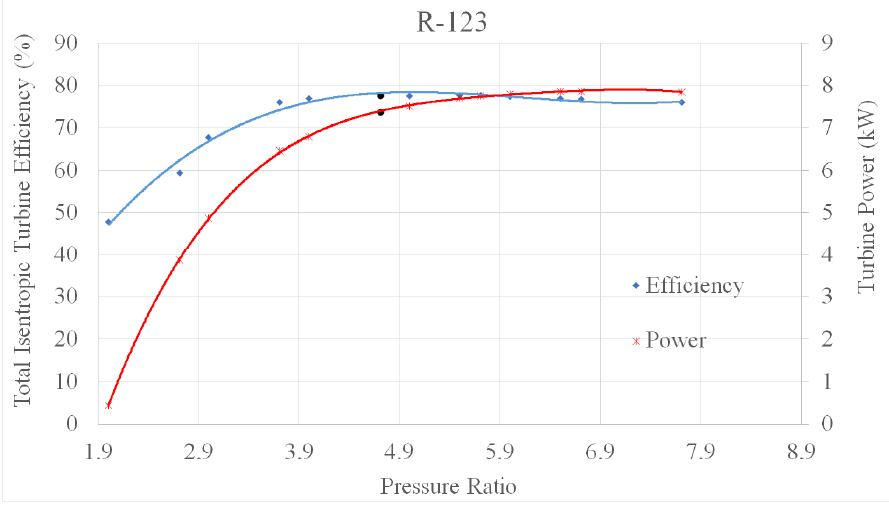
Figure 17. Variation in the total isentropic efficiency and power of the turbine operating with R-123, as a function of pressure ratio.